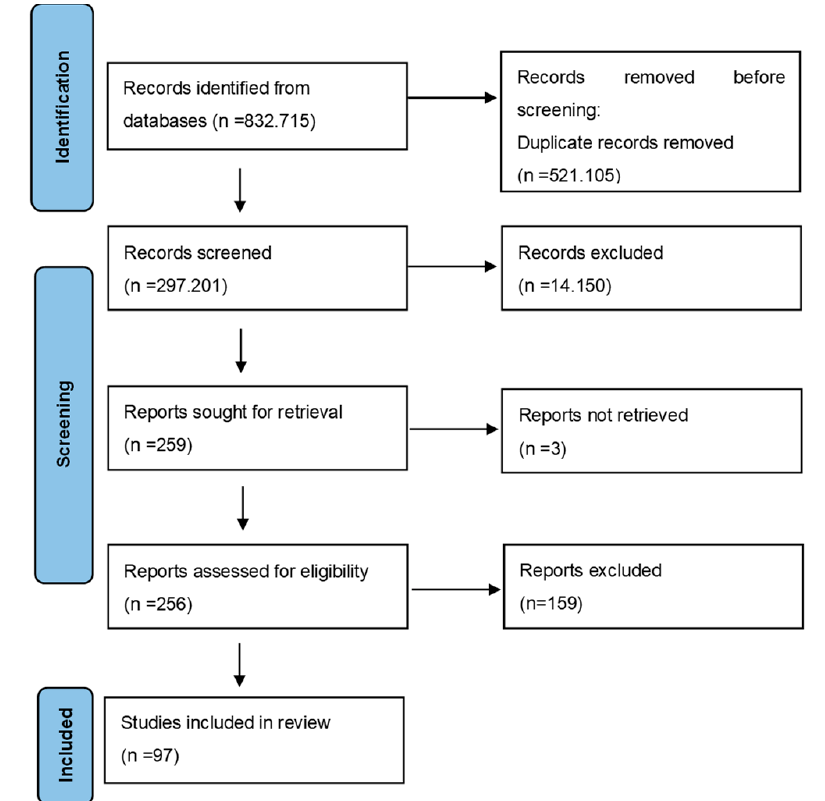
Figure 3. Prisma flow diagram.